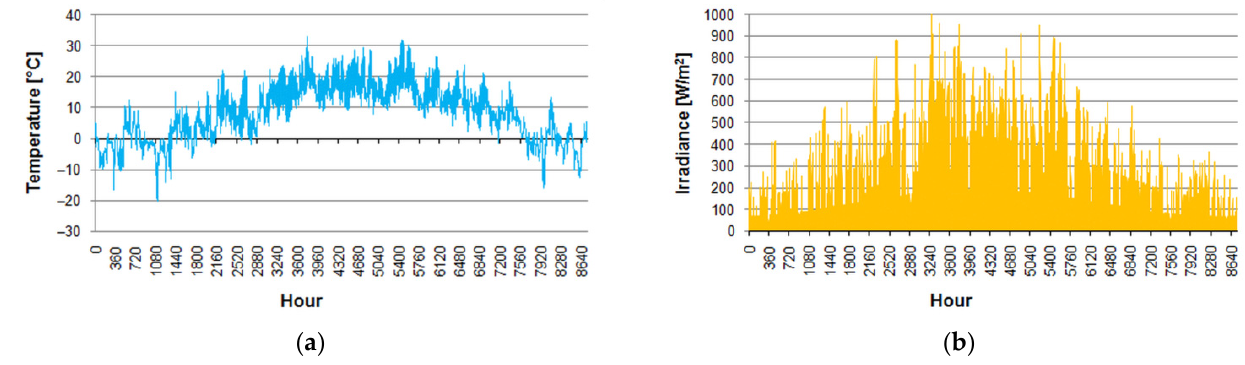
Figure 2. TMY for Kraków: ( a ) outdoor air temperature; ( b ) global horizontal irradiance.